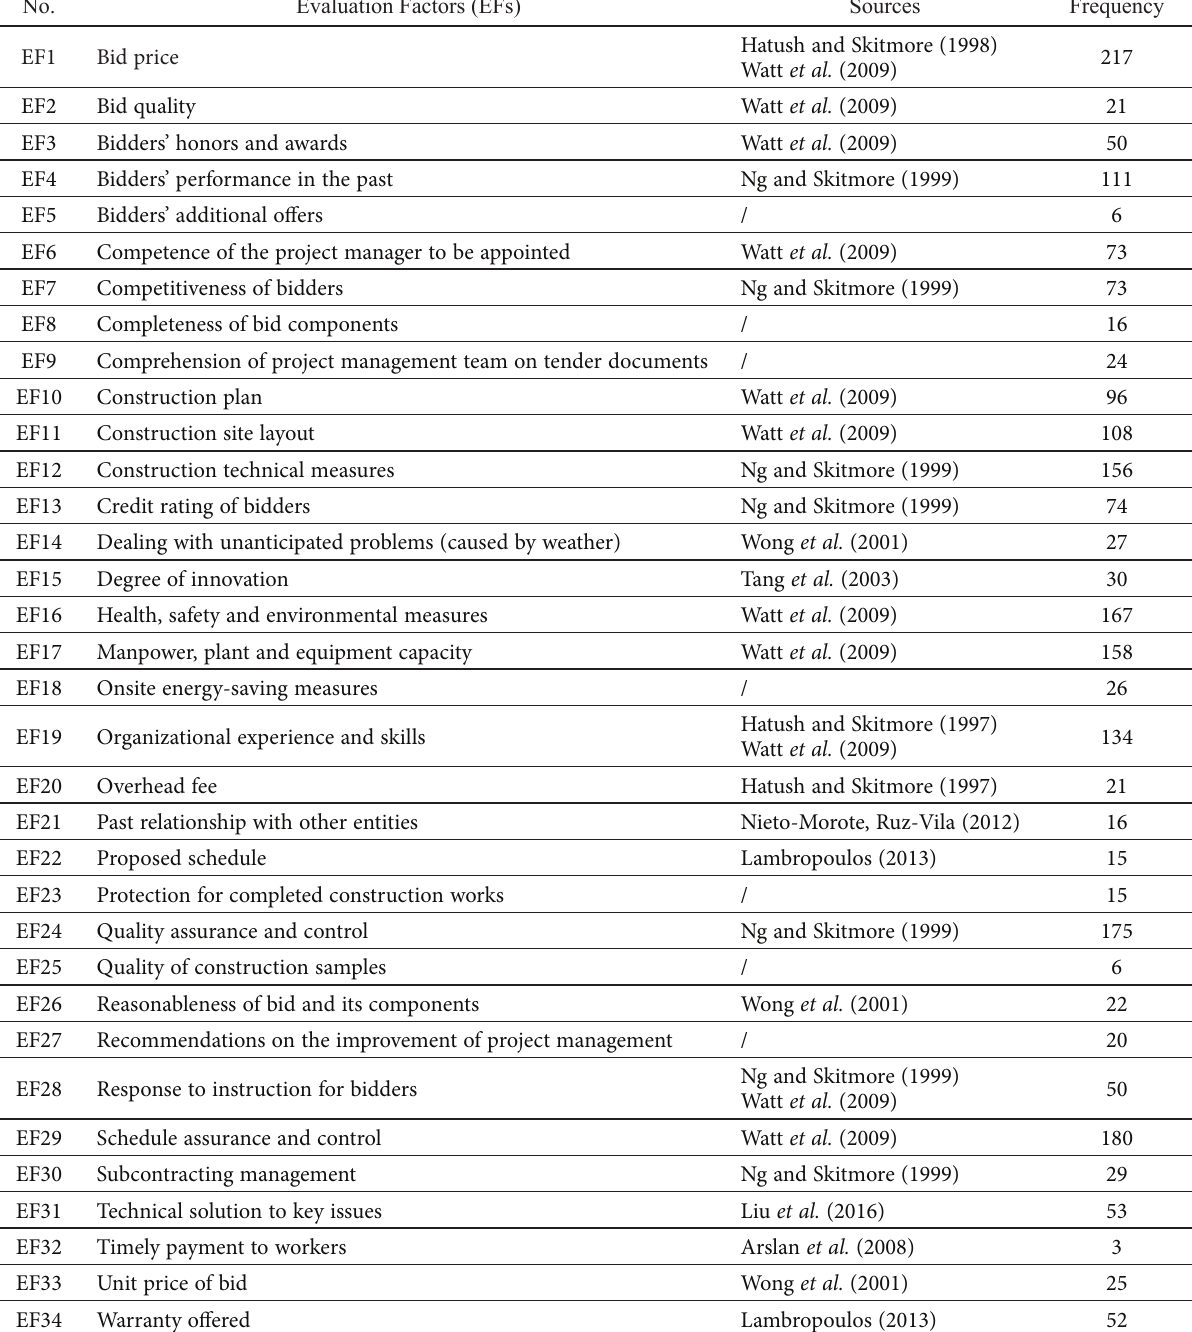
Table 3. A preliminary list of tender evaluation